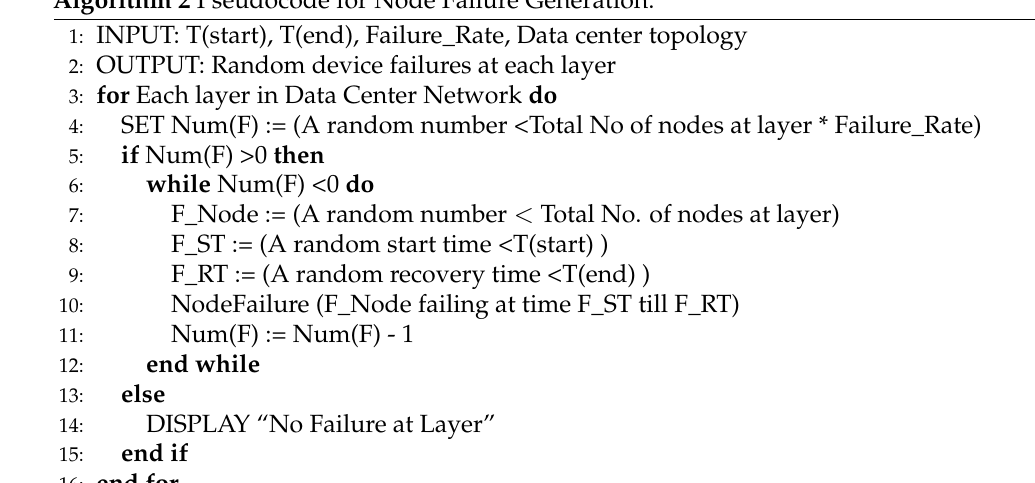
Algorithm 2 Pseudocode for Node Failure Generation.